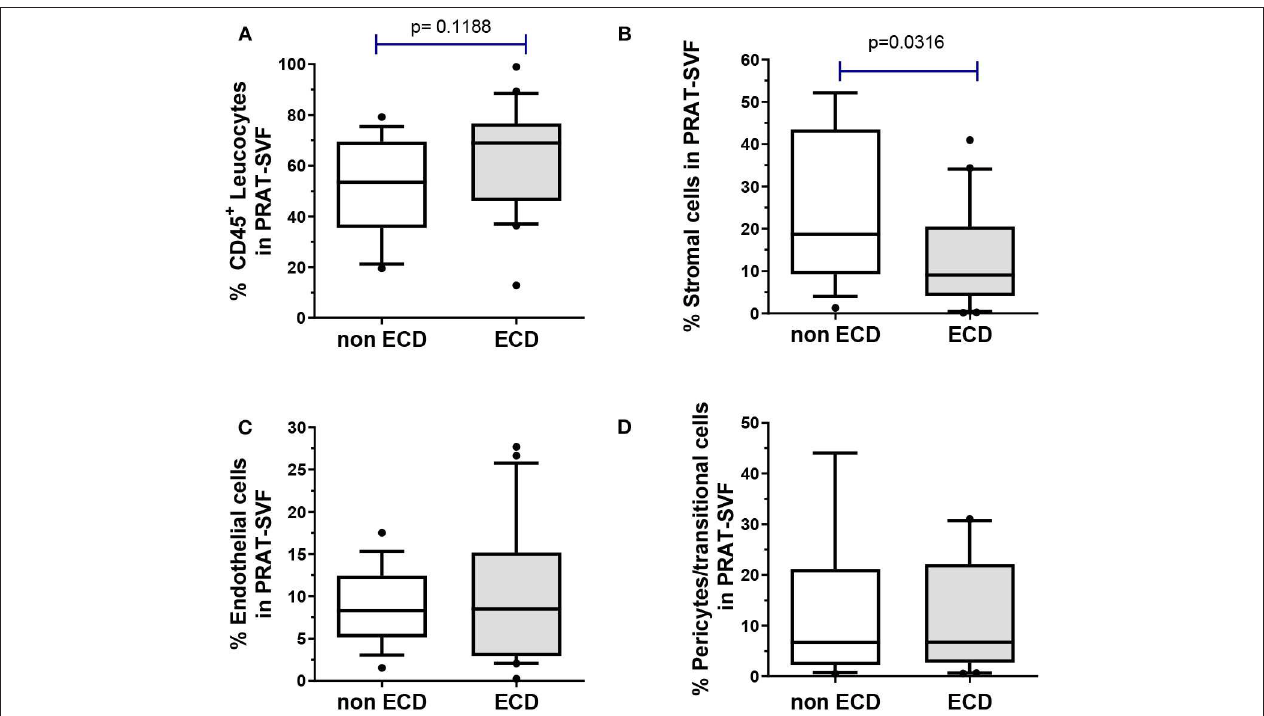
FIGURE 1 | The distribution of cell subsets composing the PRAT-SVF was determined using flow cytometry and compared between the non-ECD and ECD donors: (A) CD45 + leukocytes were comparable in the two groups (B) mesenchymal stem/stromal cells were significantly lowered in the ECD vs. non-ECD group (C) pericytes and transitional cells (D) and endothelial cells were not statistically different between the two groups. ECD, extended criteria donors. Non ECD, non-extended criteria donors. Results on the graphs are reported as box and whiskers plots representative of median values, and 25–75 interquartile ranges (Boxes) and error bars indicative of 10-90 percentile ranges. Dots indicates values out of the 10–90% quartile range.